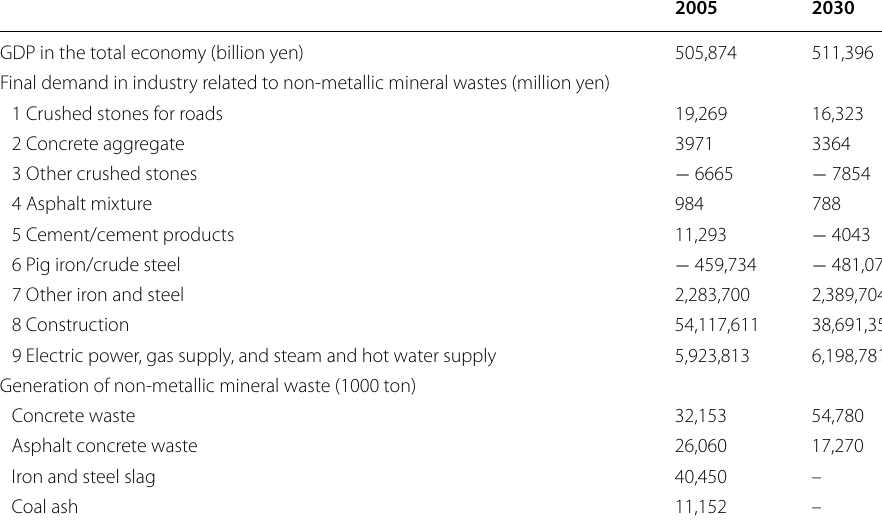
Table 4 Actual values in 2005 and predicted values in